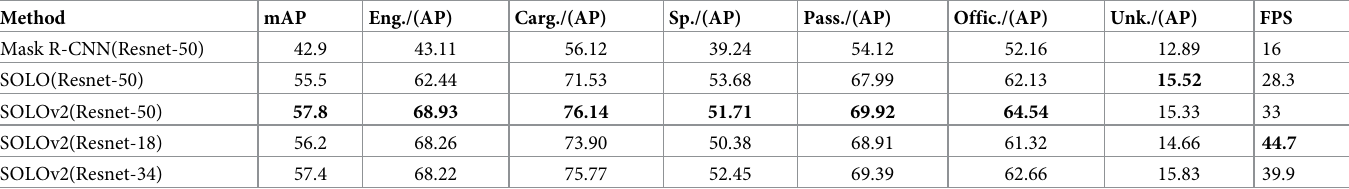
Table 5. Test results of different network structures on MariBoatsSubclass.